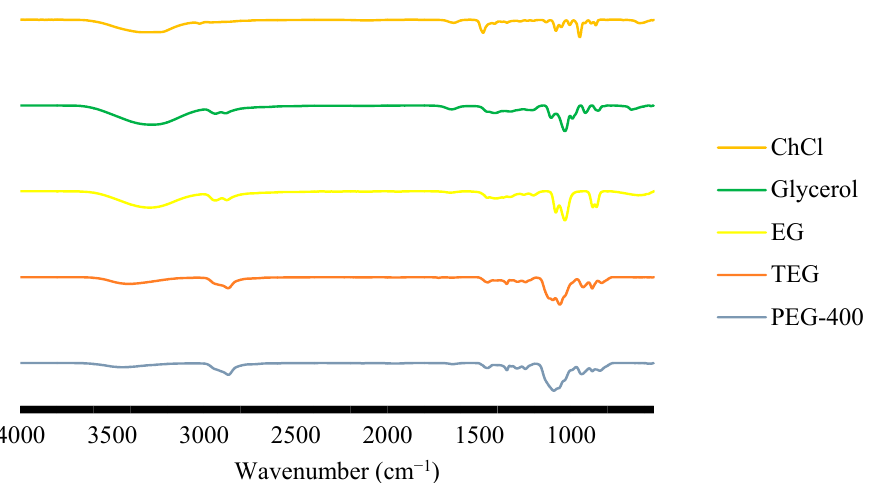
Figure 4. FTIR graph of the pure components.